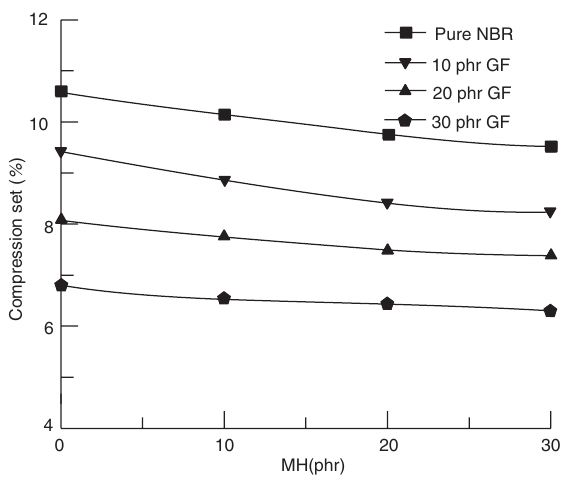
Figure 4 Compression permanent deformation curves for the nano MH/GF/NBR composite